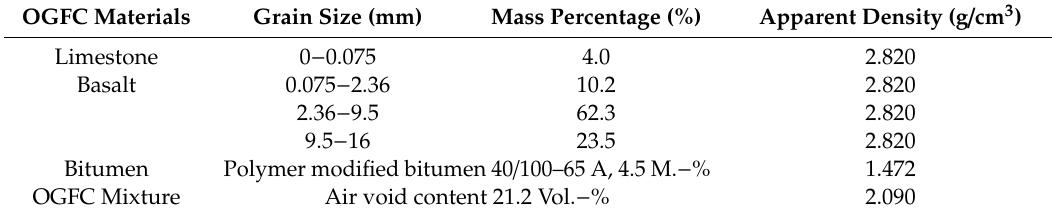
Table 2. Mix design of OGFC mixture.